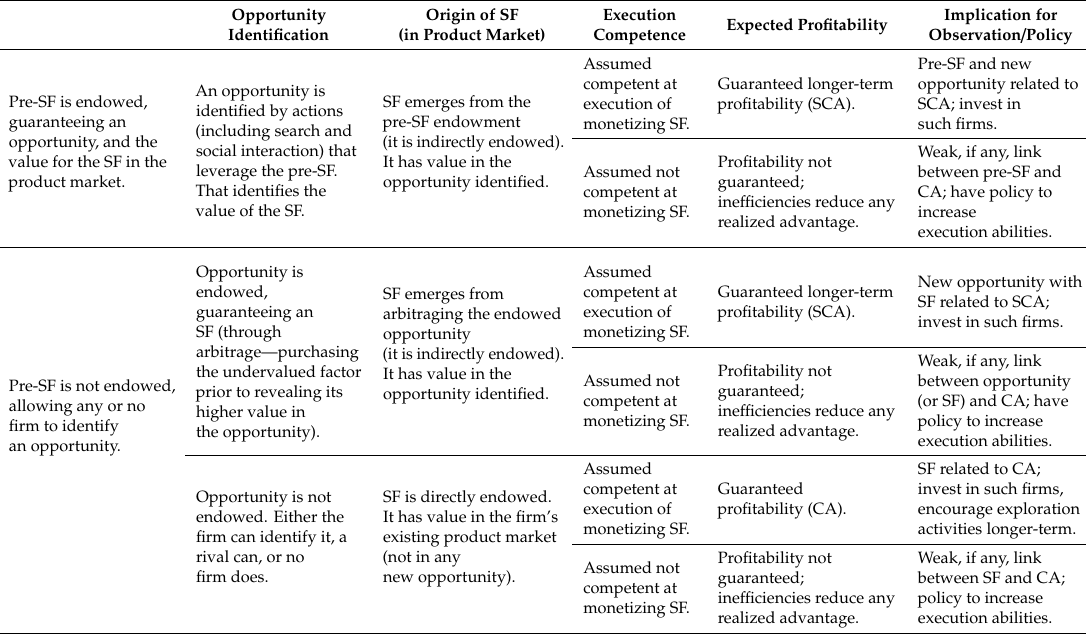
Table 2. Cases implied by a deconstructed RBV-based on three endowment